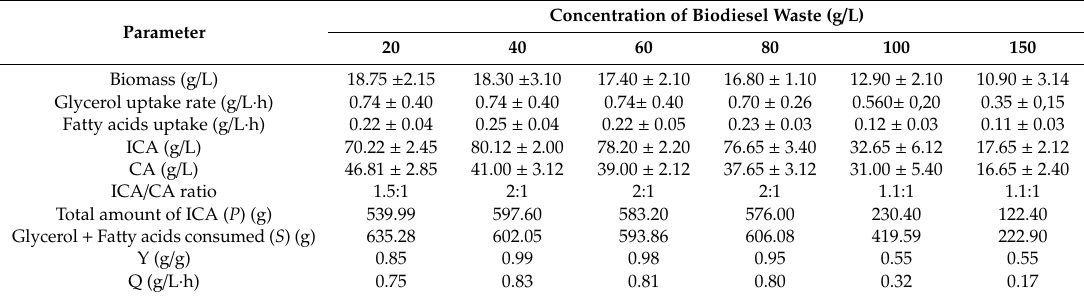
Table 3. E ff ect of the initial concentration of biodiesel waste on growth and ICA production by Y. lipolytica VKM